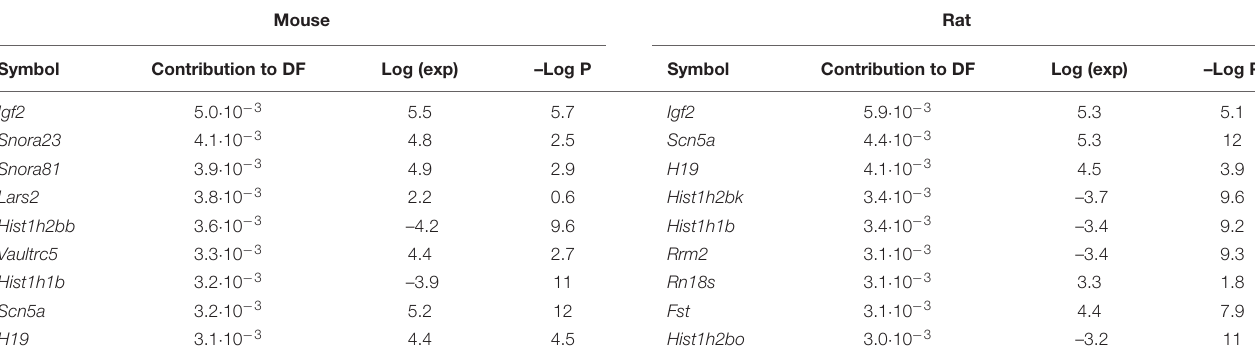
BIII 890CL did. Only a small reduction in neurite length at 10 µ